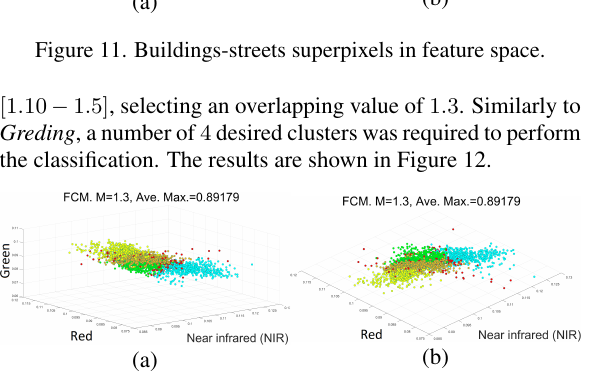
Figure 12. Buildings-streets superpixels after classification.